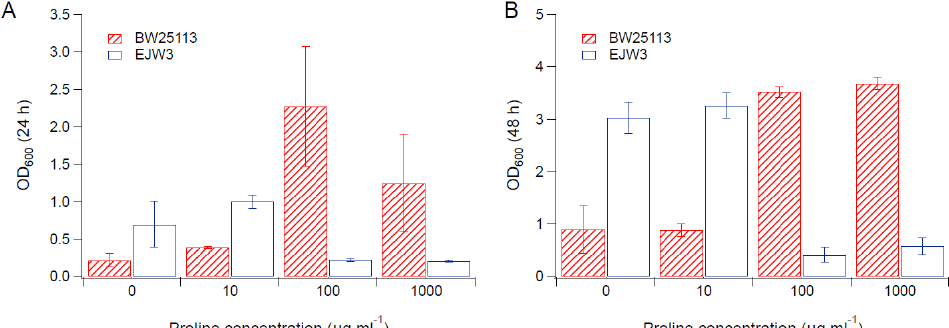
Figure 4. Cell density in M9 supplemented with 0.65 M NaCl and proline. ( A ) Cell density after 24 h. ( B ) Cell density after 48 h. Error bars are standard deviations.